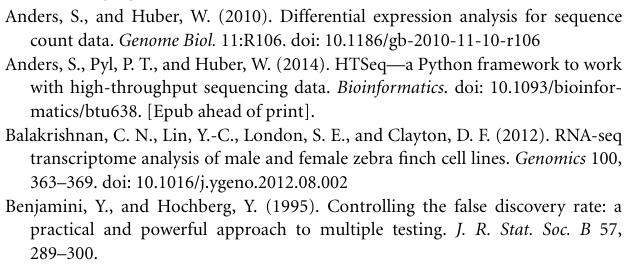
Figure S1 | Low magnification overview of miR-2954 expression in the auditory forebrain of zebra finch. Figure S2 | Cellular localization of miR-2954 expression in the auditory forebrain of zebra finch. Figure S3 | Normalized RNA-seq read counts from each of the six cell culture samples are plotted for nine of the statistically significant MAPK-related genes (Figure 5). Table S1 | Differential expression analysis (all mapped RNA-seq reads). Table S2 | Differential expression analysis (minimum 1.5-fold change). Table S3 | Overlap analysis: genes that respond to both song stimulation (auditory forebrain) and miR-2954 inhibition (G266 cell